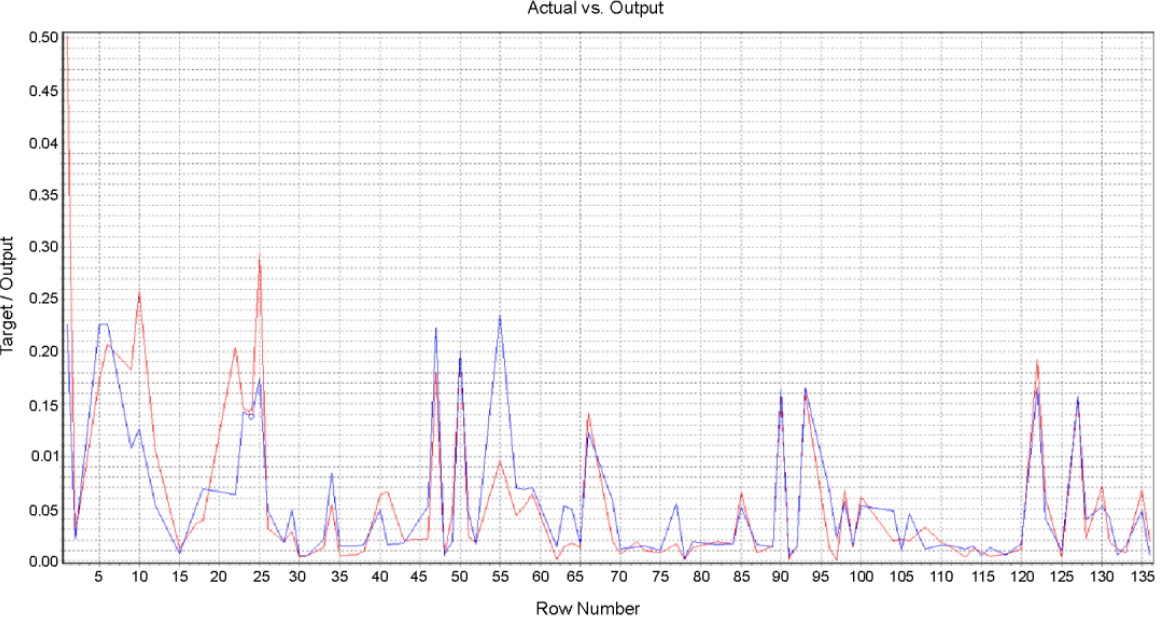
Fig. 6. Comparison of real (red line) and predicted